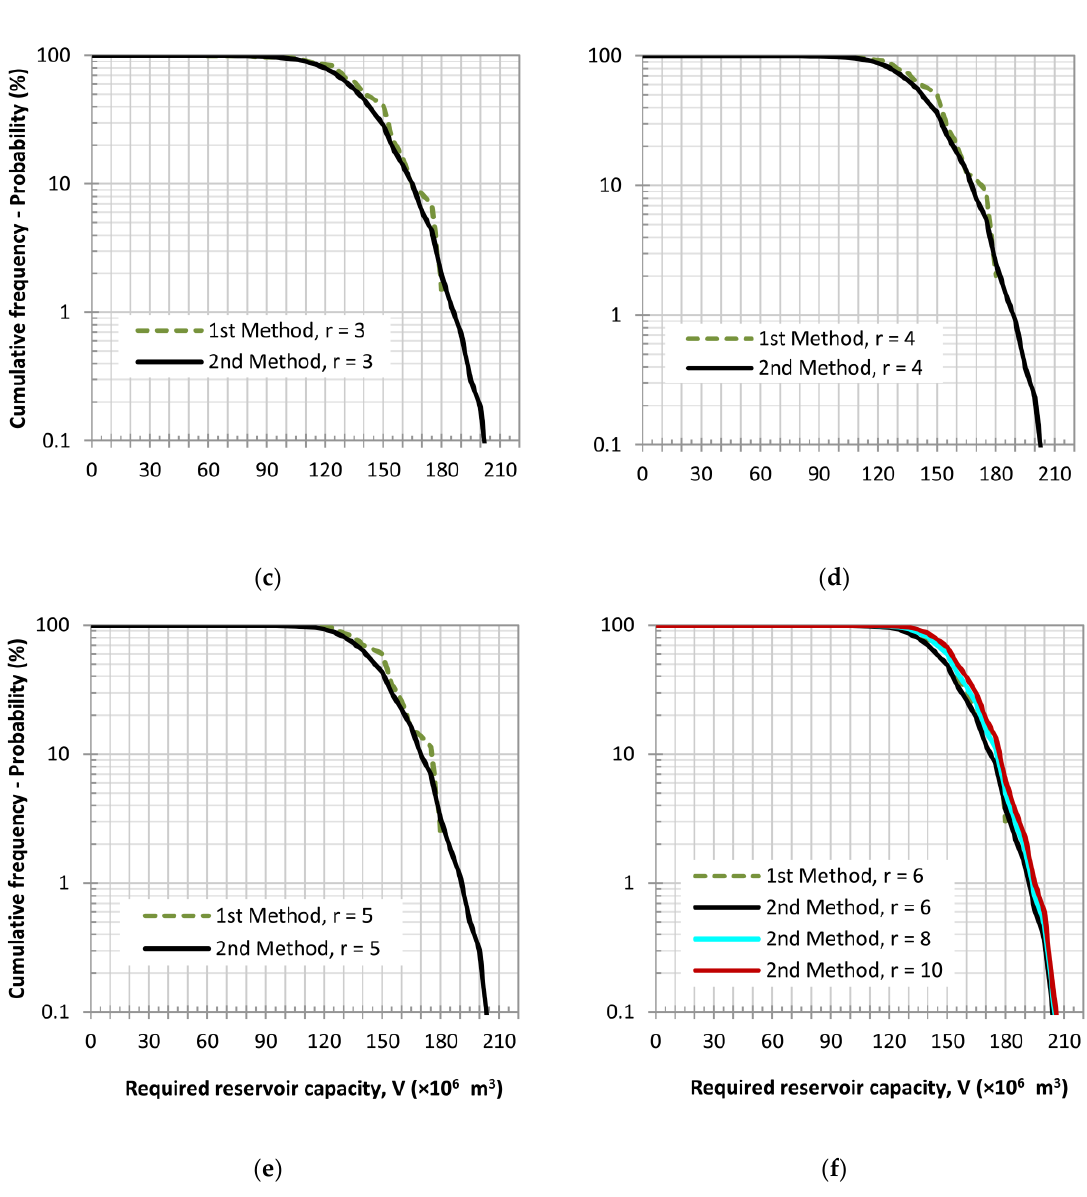
Figure 4. Probability of exceedance for any given reservoir capacity with both methods and for a regulation period of ( a ) 1 year; ( b ) 2 years; ( c ) 3 years; ( d ) 4 years; ( e ) 5 years; ( f ) 6, 8, and 10 years.